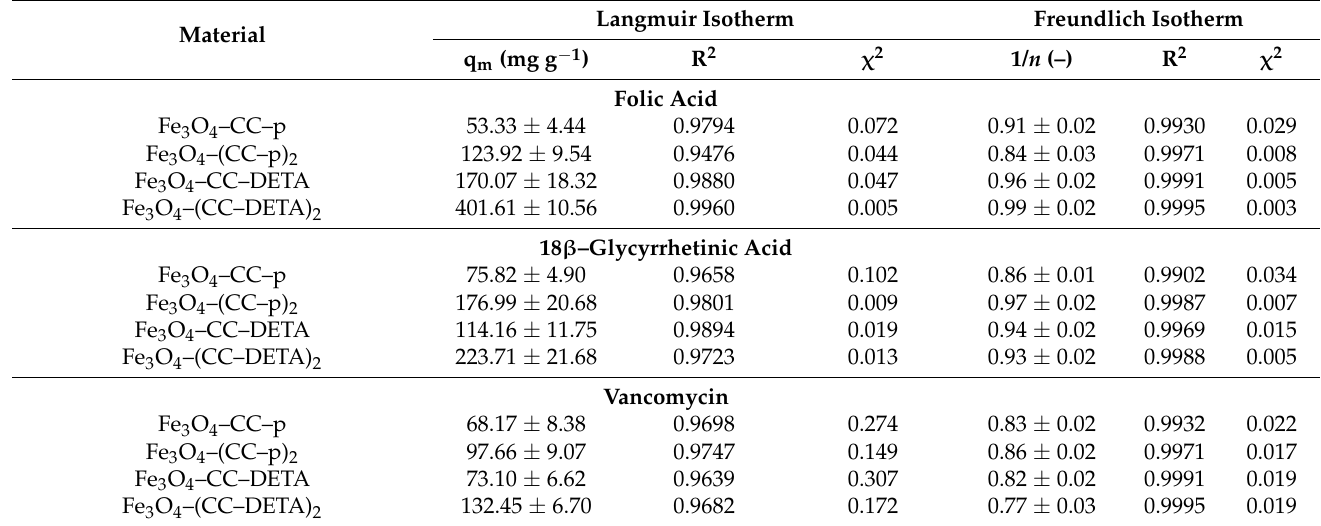
Table 2. The isothermal parameters calculated for experimental data of the drug adsorption on the synthesized materials functionalized with triazine-based